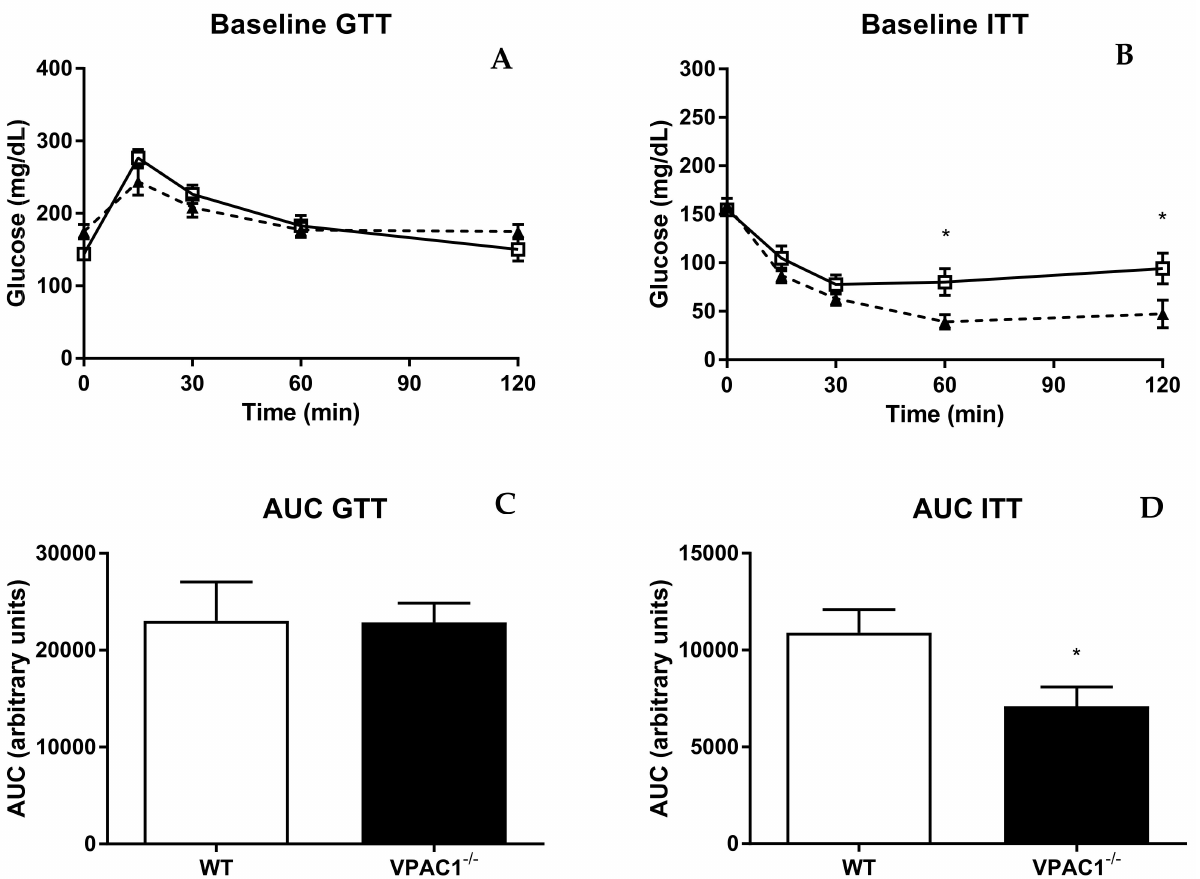
Figure 6. Glucose tolerance test (GTT) and insulin tolerance test (ITT) in WT (open square) and VPAC1 − / − mice (closed triangle). Blood glucose values ( A , C ) and area under the curve (AUC) of glycemia analysis ( B , D ) of blood glucose levels. An unpaired t -test was used to compare time points post glucose/insulin infusion in WT mice and VPAC1 − / − mice. A two-factor ANOVA analysis was used to compare AUC values between WT and VPAC1 − / − mice. Values are means ± SEMs; * p <